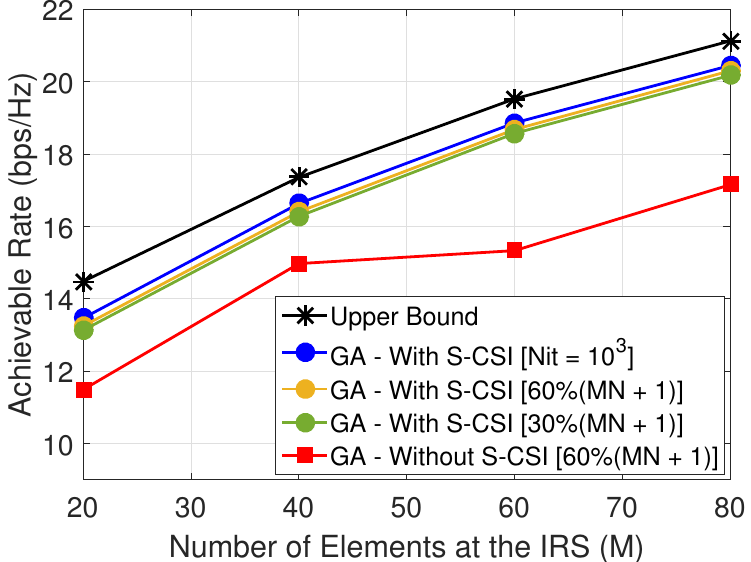
Figure 8. Training overhead of the proposed solution for ( x u , y u ) = (95,8) m, i.e., d IU ∼ 5